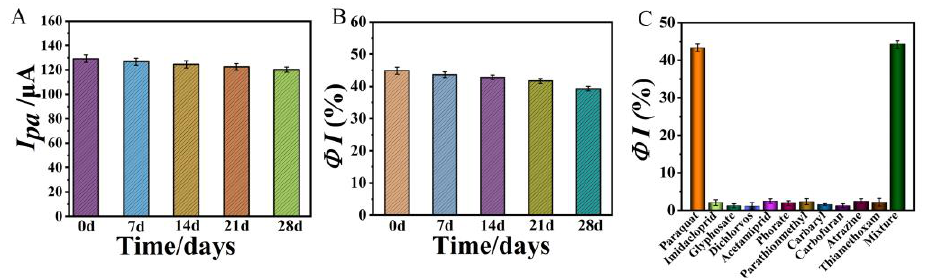
Figure 11. ( A ) Stability of the proposed aptasensor in 0.1 M PBS, ( B ) Stability of the proposed aptasensor for detection of PQ (10 mg/L), ( C ) Selectivity of the proposed aptasensor for PQ detection. Error bars were obtained as the standard deviation of triple measurements ( n = 3).